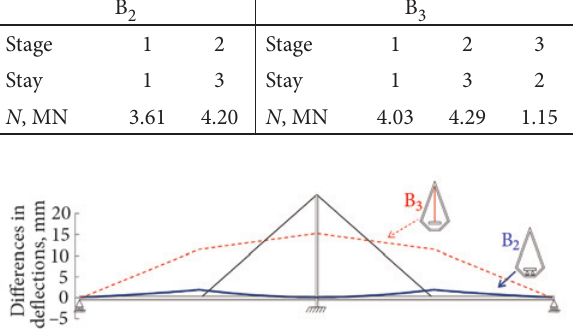
fig. 2. Differences between the vertical deflections obtained in B 2 and B 3 in the deck in the OSS and the vertical deflections in the equivalent continuous beam, B 0 , mm